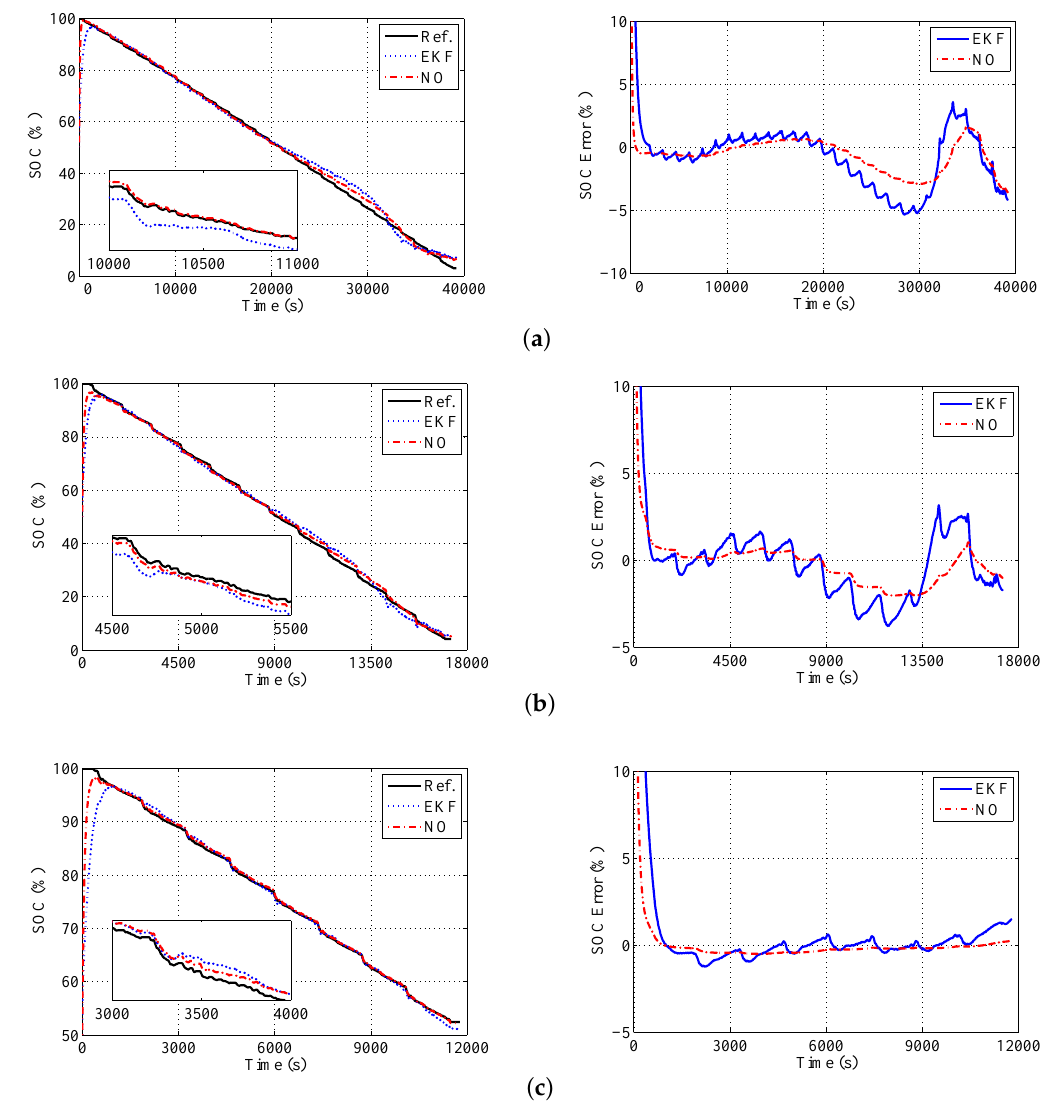
Figure 7. Estimation results of FUDS datasets from type 2 cell at different temperatures: ( a ) estimation results at 10 ◦ C ; ( b ) estimation results at 20 ◦ C ; and ( c ) estimation results at 40 ◦ C